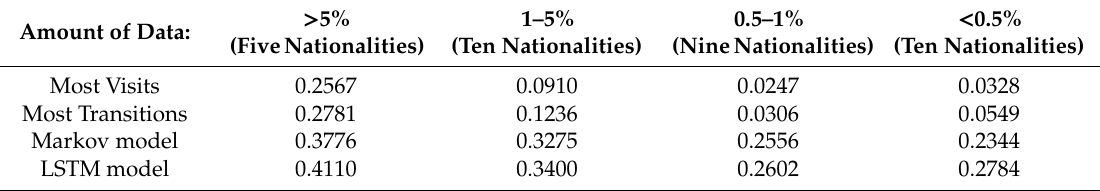
Table 5. Macro-average F1-score for nationalities in di ff erent ranges of amount of data. The percentage value in the first row refers to the amount of data represented by each nationality in that column with respect to the whole